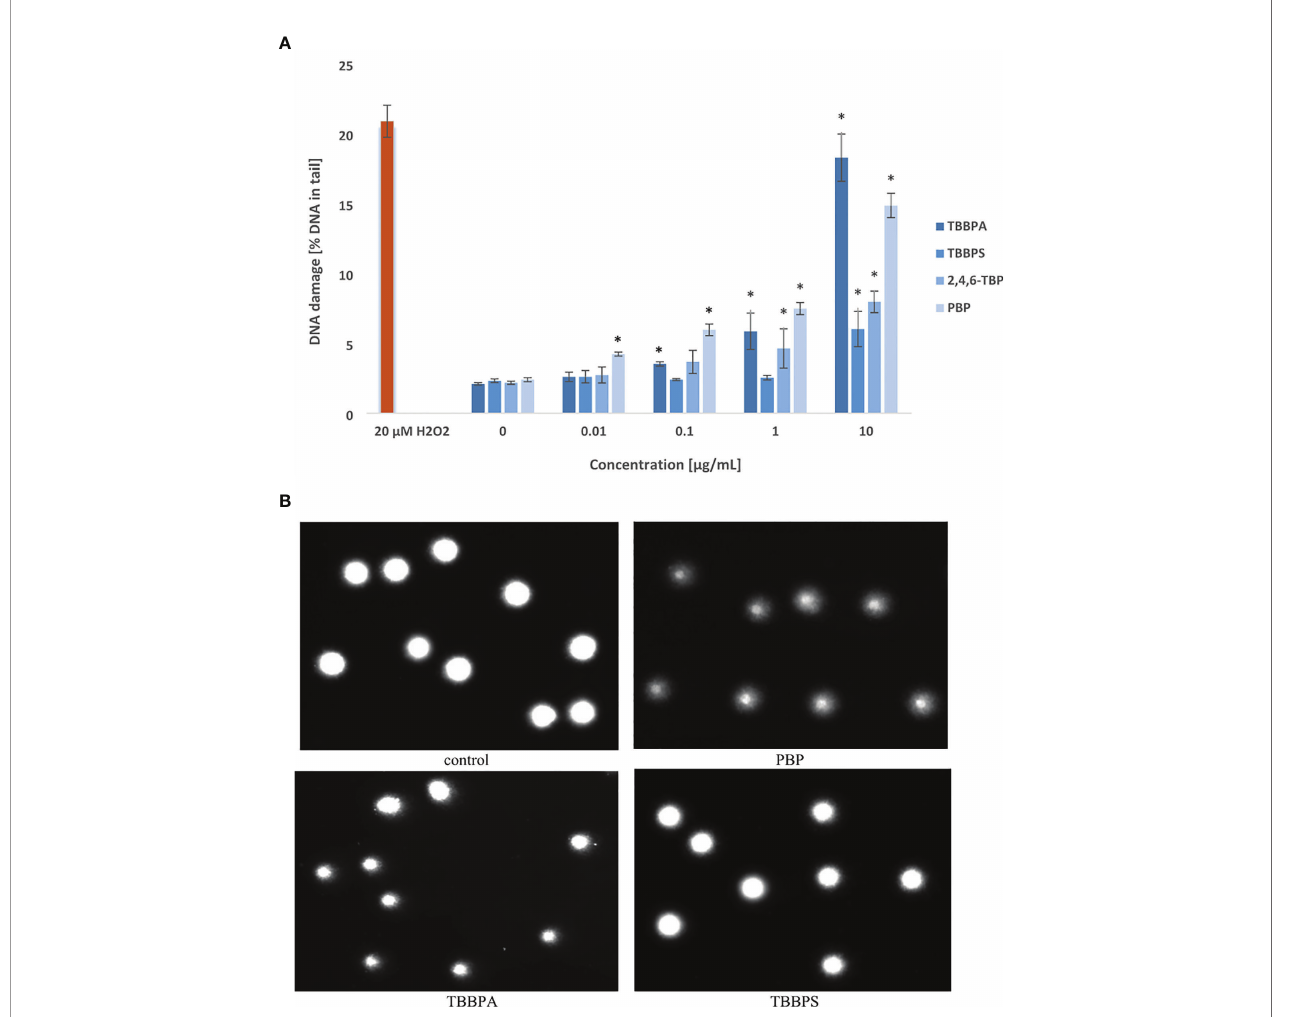
FIGURE 1 | Total DNA strand breaks formation. (A) SSBs and DSBs formation in human PBMCs treated with TBBPA, TBBPS, 2,4,6-TBP and PBP at the concentrations of 0.01 µg/mL, 0.1 µg/mL, 1 µg/mL and 10 µg/mL for 24 h DNA damage was measured as the percentage of DNA in the comet tail using the alkaline version of the comet assay. Mean ± SD was calculated from 3 individual experiments (3 blood donors). Statistically different from negative control at *P<0.05. Statistical analysis was conducted using one-way ANOVA and a posteriori Tukey test. (B) Selected photographs of damaged DNA (comets) of human BPMCs incubated with DMSO at 0.2% (negative control) and tested BFRs at 1 µg/mL (comet assay, alkaline version). The photos were obtained using fl uorescent microscope with 200x magni fi